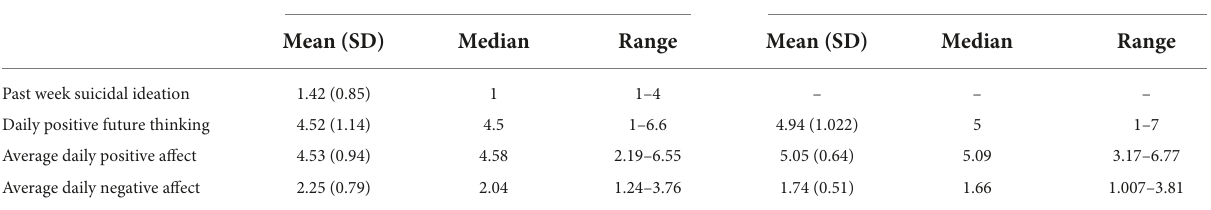
TABLE 2 Variable descriptives for adolescents reporting vs. not reporting past-week suicidal ideation.